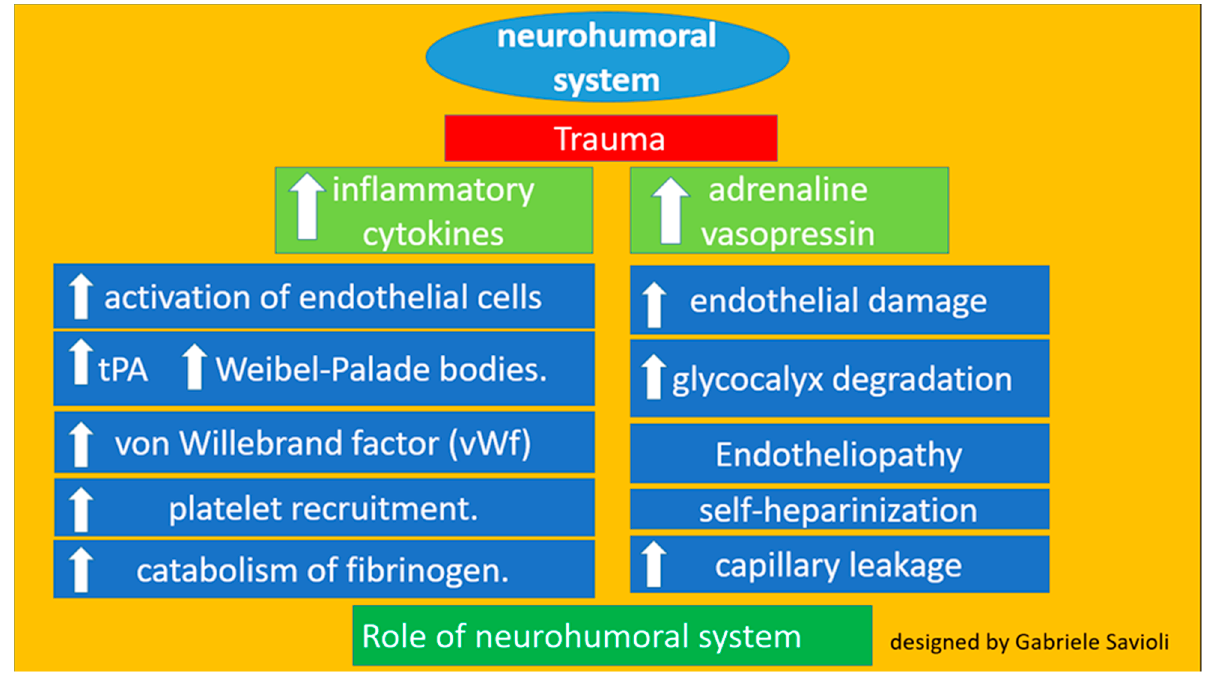
Figure 4. Role of the neurohumoral system.